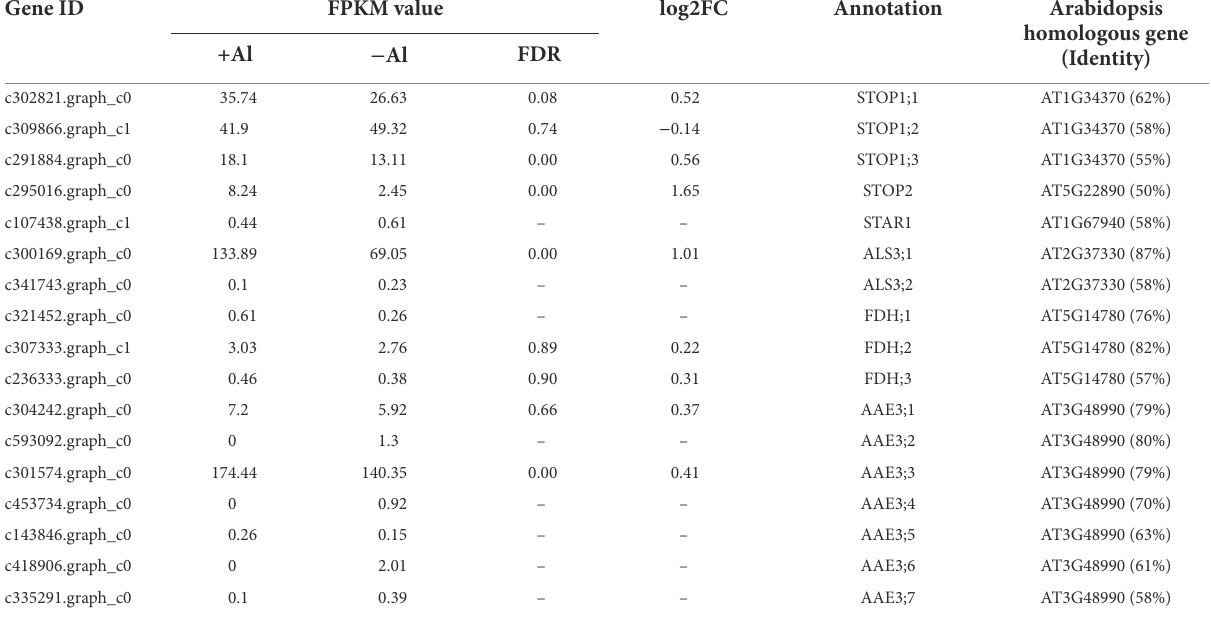
TABLE 1 Identification of known Al-tolerance gene homologs in RNA-seq. Gene ID FPKM value